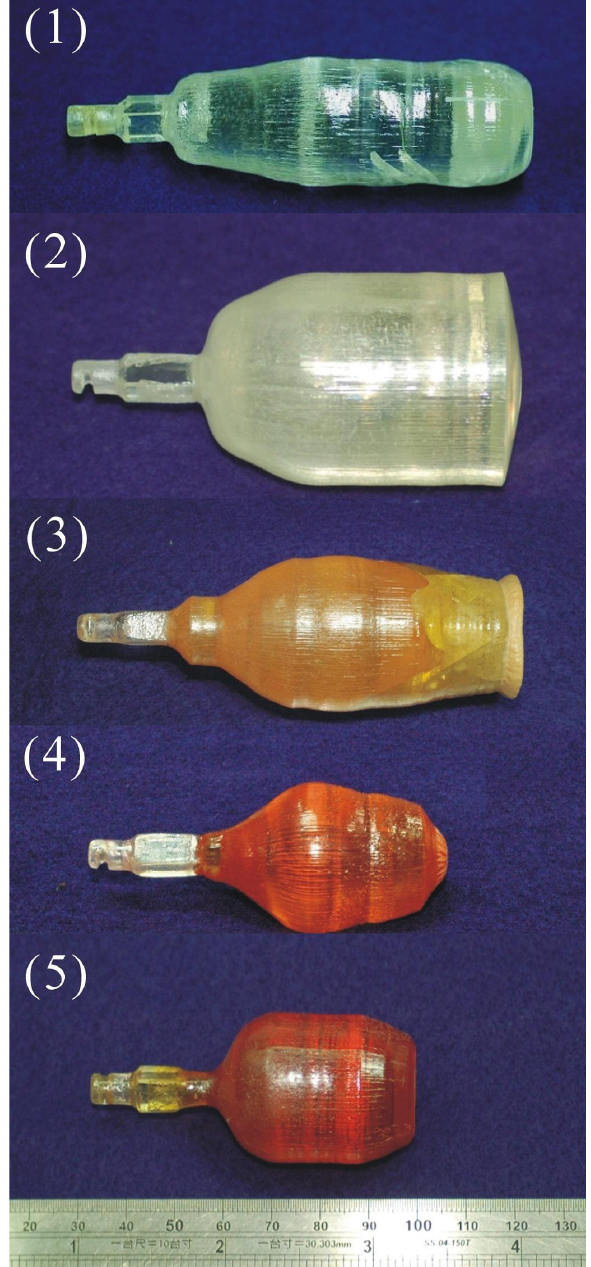
Figure 1. Photograph of the as grown stoichiometric lithium tantalite (SLT)